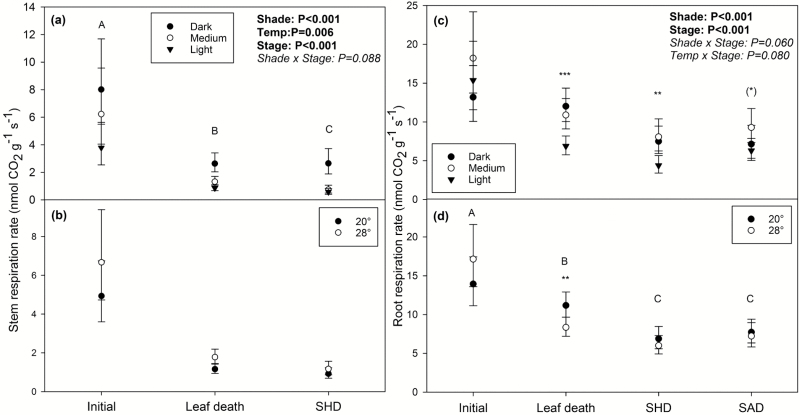
Stem and root mass-specific respiration rates throughout starvation by initial, pre-darkness shade treatment and temperature of darkness treatment. Mass-specific stem (a, b) and root (c, d) respiration were measured during harvests for initial measurements (i.e. pre-darkness), during leaf death, and when the top half of the stem had died (SHD). Root respiration was also measured when the whole stem had died (SAD). Means are back-transformed and error bars represent 95% CI. Only significant or marginal effects from the complete three-way ANOVA (stage, initial shade, temperature) are listed. D, M, and L indicate the initial dark-, medium-, and light-shade treatments, respectively. Different letters represent significant differences between stages of starvation across darkness temperatures and initial shade treatments. Asterisks indicate significant temperature (b, d) or initial shade treatment effects (a, c) at each stage: (*)P<0.10, *P<0.05, **P<0.01, ***P<0.001. For each shade treatment×temperature combination, n=4–5 at initial harvest, n=10–11 at leaf death, n=5–7 at SHD, and n=3–7 at SAD.